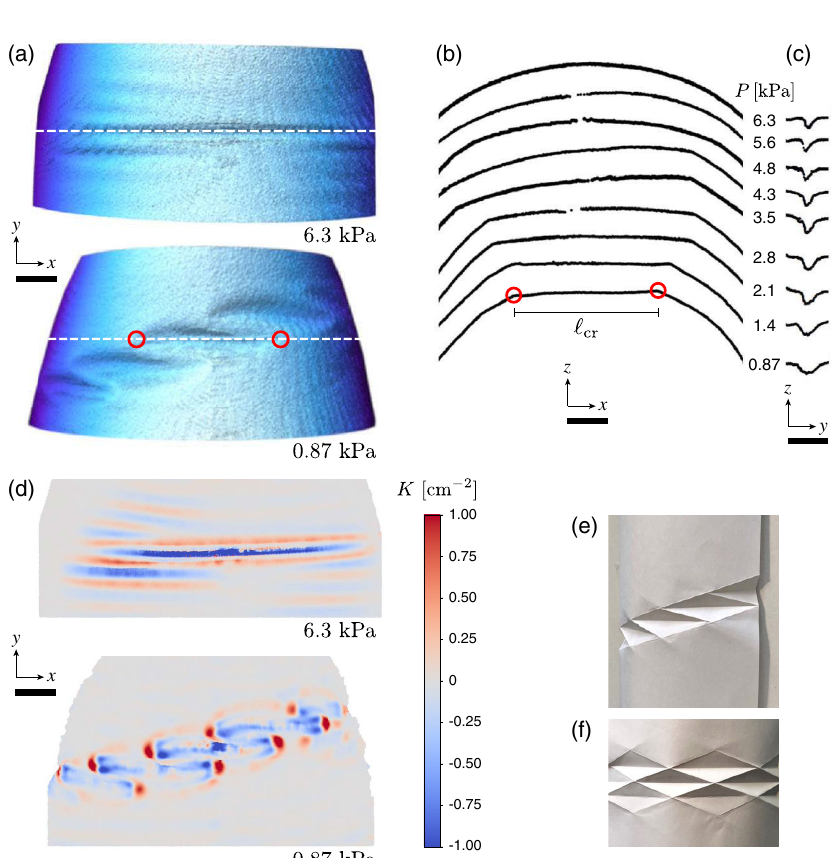
FIG. 3. Crumple morphology. (a) Renderings of three-dimensional scans of an inflated square polyethylene bag ( t ¼ 49 μ m, E ¼ 297 MPa, W ¼ 20 cm), showing the topography of wrinkles (top) and crumples (bottom). (b) Cross sections through a single buckled feature as a function of the gauge pressure. The profiles are taken along the dashed lines in (a), and the two circles highlight the sharp tips at the two ends of the crumple. (c) Cross sections along a perpendicular direction, which show only a small change in width through the transition [the same scale as (a),(b)]. (d) Local Gaussian curvature K for the scans shown in (a). The wrinkled state (top) shows large positive and negative curvatures along the wrinkle crests and troughs. The crumpled state (bottom) localizes K and, hence, material stresses. Scale bars in (a) – (d), 1 cm. (e),(f) Origami patterns resembling crumpled states, suggesting that crumples may be an approximate isometry of the plane, with localized bending and stretching in place of the edges and vertices in these paper